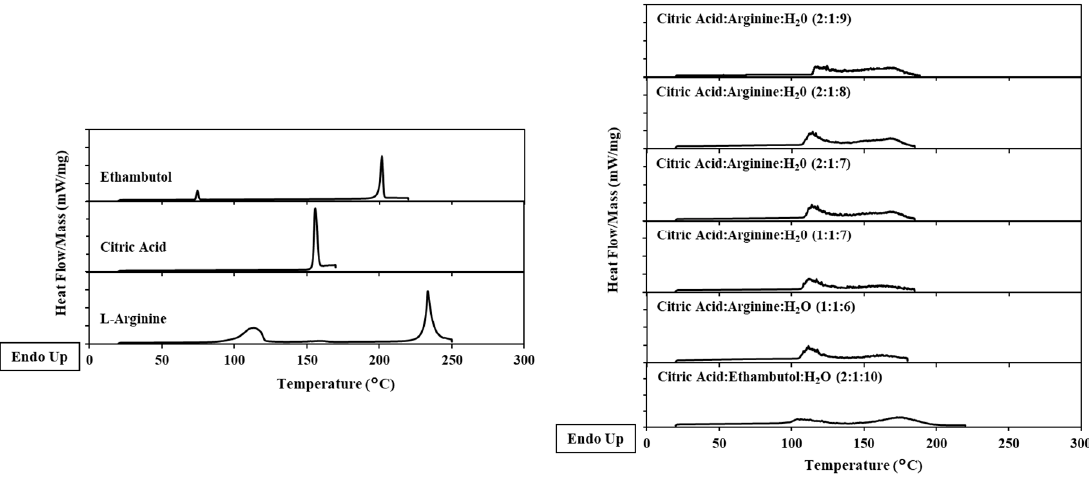
Figure 2. Thermograms obtained in hermetic capsules of initial components ( a ) and THEDES ( b ).